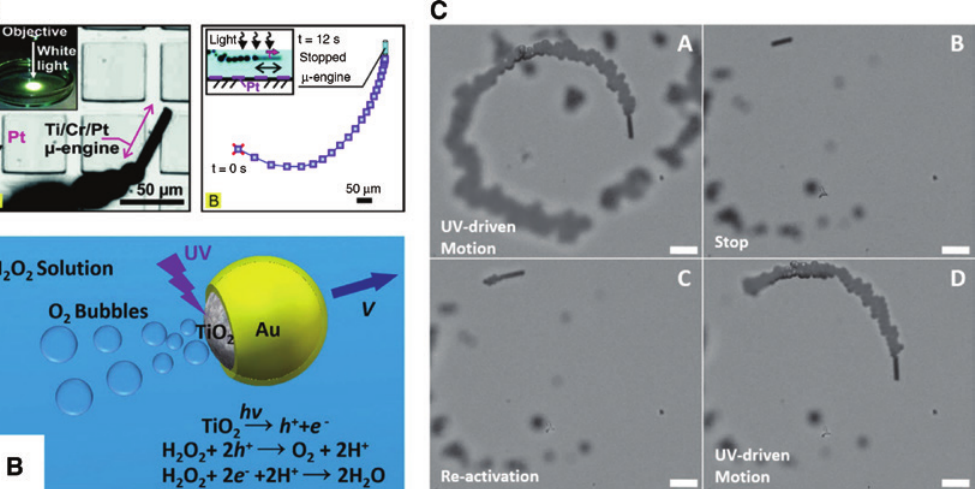
Figure 4: Light-driven micro/nanomotors with bubble-induced propulsion. (A) Ti/Cr/Pt micromotor with propulsion force originated from O bubbles. Its motion can be controlled by white light intensity [88]. Copyright 2011, Wiley-VCH. (B) Schematic of the TiO 2 micromotor working with oxygen bubbles, which were generated under UV irradiation [65]. Copyright 2016, The Royal Society of Chemistry. (C) Snapshots of the light-controlled motion of TiO